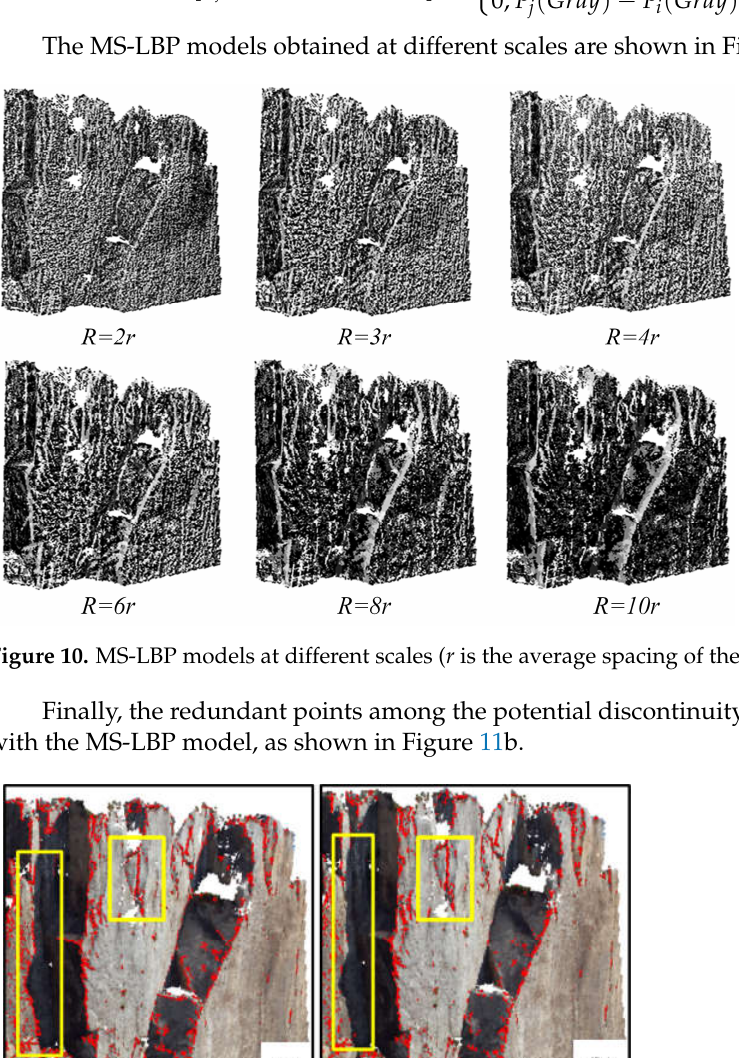
Figure 11. Diagram of discontinuity trace points. ( a ) The result without the MS-LBP constraint; ( b ) the result of adding the MS-LBP constraint.